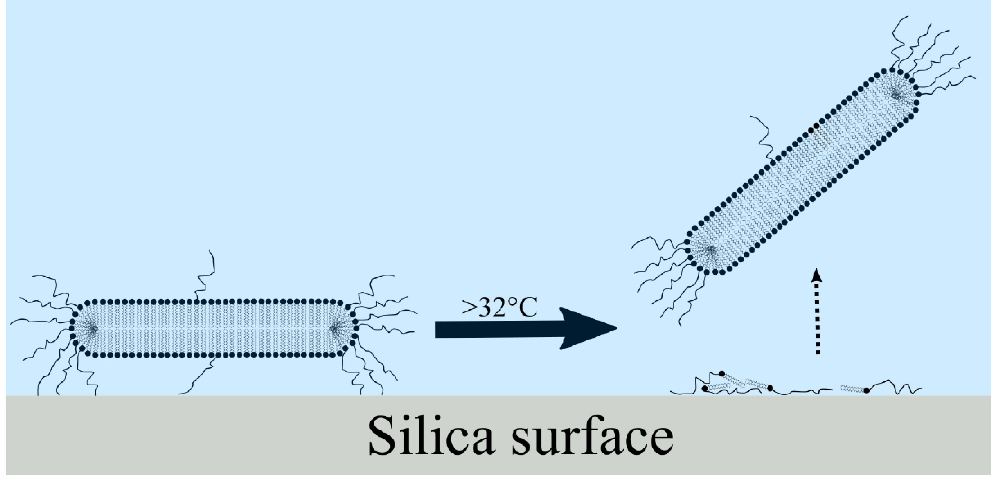
Figure 4. Schematic illustration of the proposed rearrangement of lipodisks on silica surfaces at temperatures higher than 32 °C . PEGylated lipids are pulled out of the lipodisk and remain attached to the surface. The rest of the disk departs from the surface, probably as a disks with lower PEG content than before the attachment.